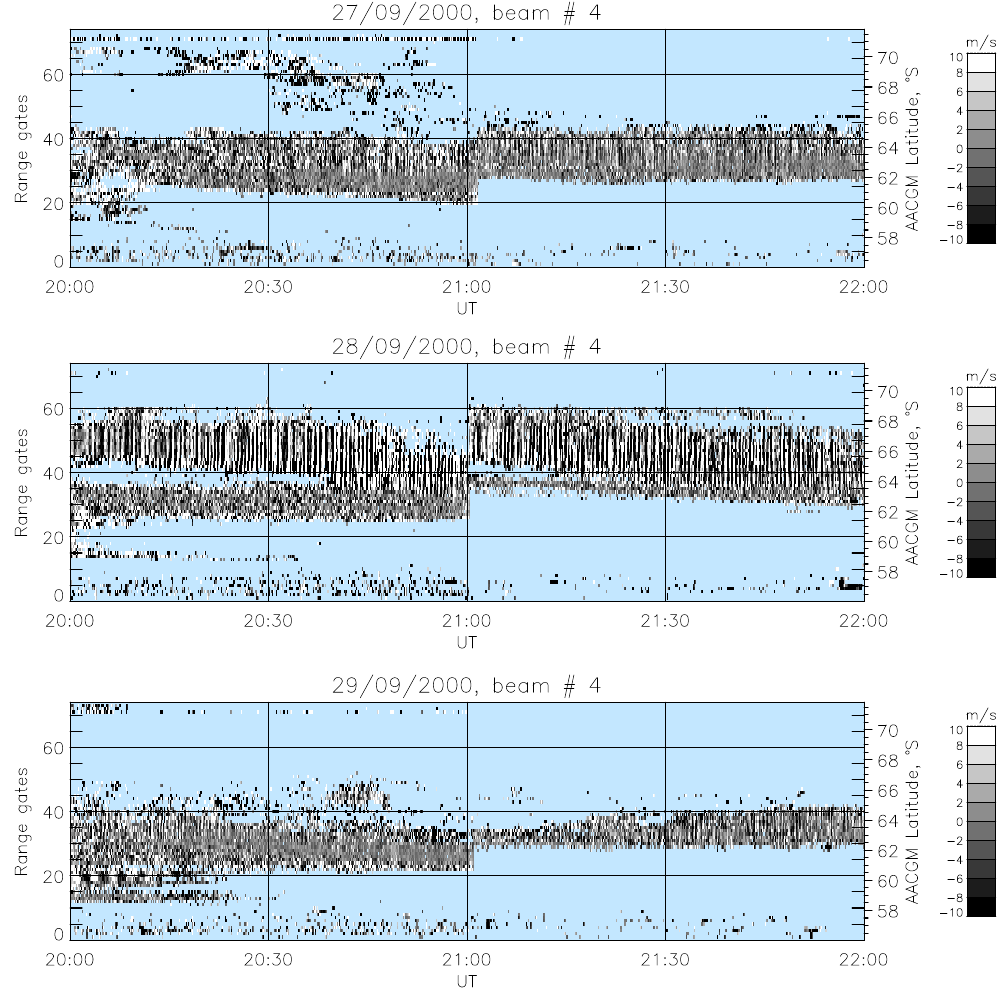
Fig. 2. FITACF output Doppler velocity for beam #4 during 20:00–22:00 UT, 27–29 September 2000 (MLT ’ UT+13:30) after removing single spikes and detrending with a 5-min box-car window. Right axis corresponds to the AACGM latitude of ionospheric reflection region for sea-scatter echoes. Blue-shaded areas depict invalid or no data. AACGM latitude of MQI approximately corresponds to that of gate #43, but it is shifted from beam #4 in magnetic longitude by ’ 22 ◦ ( ’ 1 . 5h MLT)